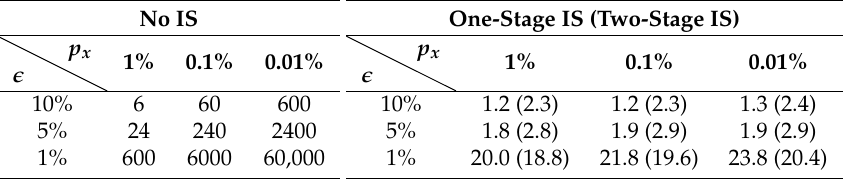
Table 3. This table reports the time (in seconds) required to achieve a given degree of accuracy (computed using Equation (48)) for several values of p x and (cid:101) , for the parameter values corresponding to the left panel of Figure 7. Note that this is for the one-factor model. Values of c and d are obtained from the lines of best fit appearing in the left panel of Figure 7, values of a and b are obtained from Table 1.